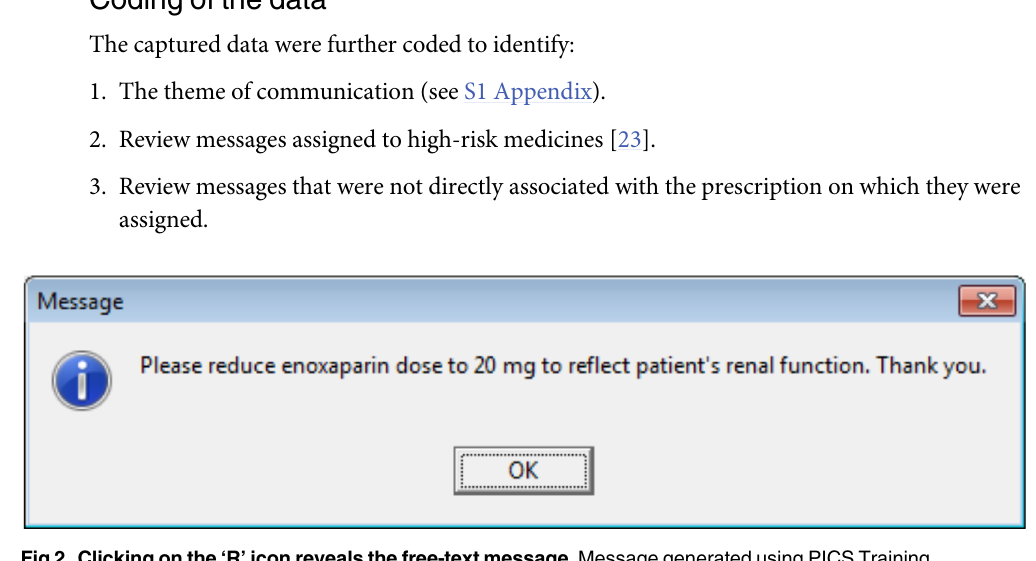
Fig 2. Clicking on the ‘ R ’ icon reveals the free-text message. Message generated using PICS Training